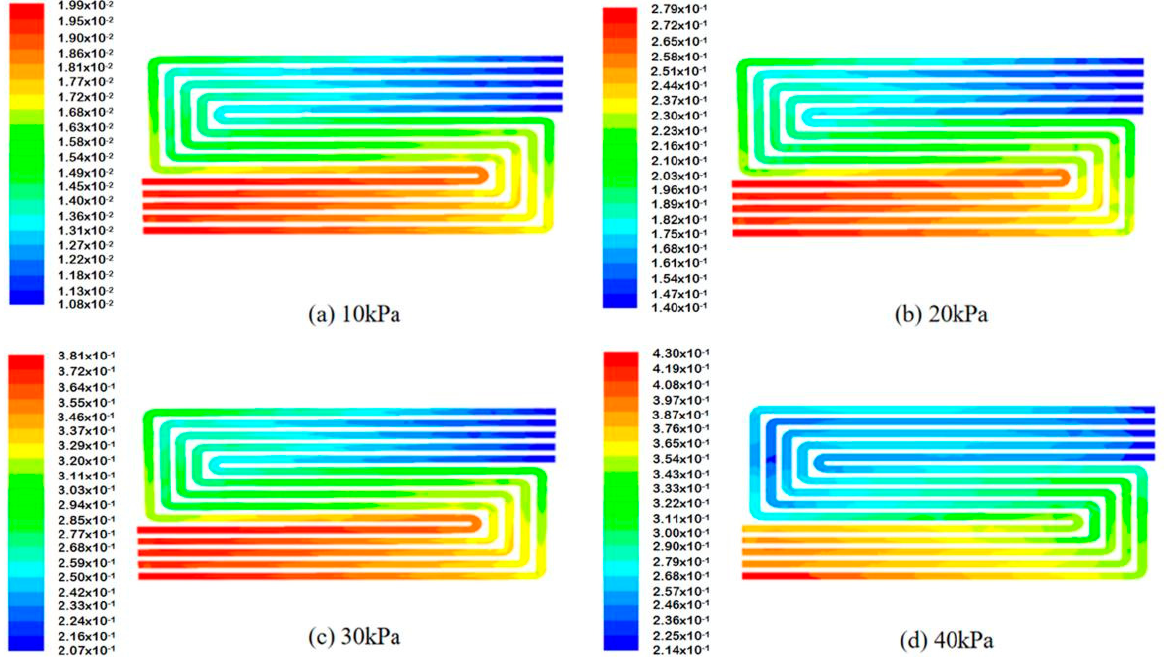
Figure 3. Water content in the cathode channel under different inlet pressures: ( a ) 10 kPa, ( b ) 20 kPa, ( c ) 30 kPa, ( d ) 40 kPa.